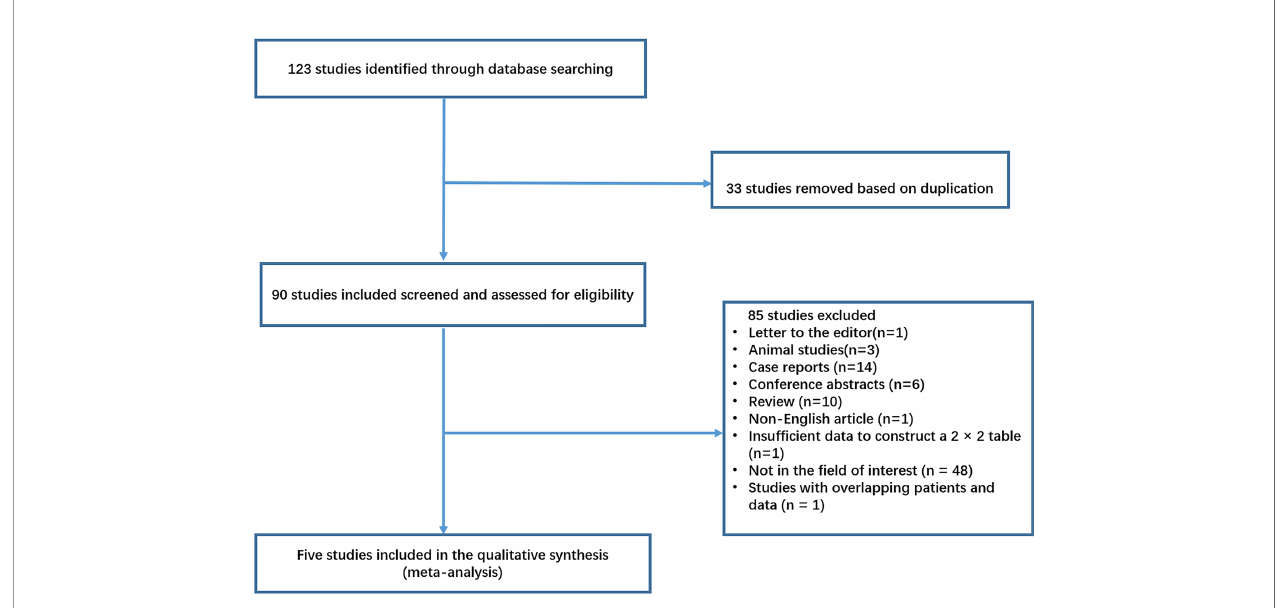
FIGURE 1 | Flowchart showing selection process for